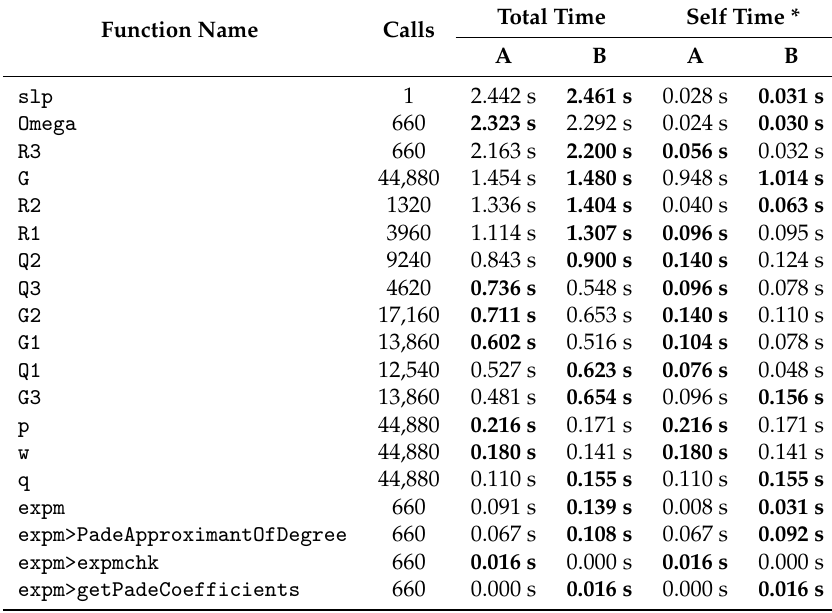
Table A1. Profile summary of the slp function generated by Matlab with m = 10, n = 10, and L = 5 for finding the eigenvalue in: ( A ) the interval [ 0,10 ] for y (cid:48)(cid:48) + λ y = 0, y ( 0 ) = y ( 1 ) = 0; and ( B ) the interval [ 0,2 ] for y (cid:48)(cid:48) + ( x + 0.1 ) − 2 y = λ y , y ( 0 ) = y ( π ) = 0. * Self time is the time spent in a function excluding the time spent in its child functions. Self time also includes overhead resulting from the process of profiling. All time values are in